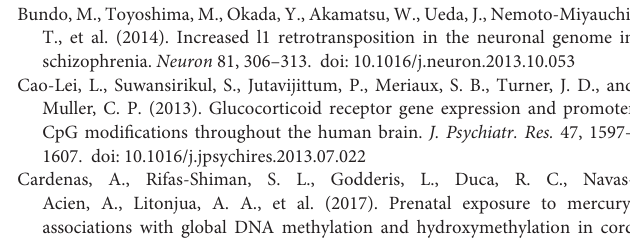
Supplementary Figure 1 | Representation of the linearity of expression levels for methylase and demethylase enzymes. (A) ALKBH1 vs. METLL4; (B) ALKBH1 vs. N6AMT1. Data from the GTEX portal on August 19th, (dbGaP Accession phs000424.v8.p2, 19/08/2020) (linear relationship was evaluated by Pearson analysis, R2 given in each panel, p < 0.01 in both cases). Supplementary Figure 2 | (A) Genotype-Tissue Expression data for human N6AMT1. Data were downloaded from the GTEX portal on August 19th, (dbGaP Accession phs000424.v8.p2, 19/08/2020). (B) Hierarchical clustering of sequence alignment and percentage sequence similarity for the methyl transferase N6AMT1. Supplementary Figure 3 | (A) Representative membranes for dot-blot quantification of the artificially methylated DNA control to demonstrate the lack of binding in synthetic DNA without 6mA and the strong signal from the artificially modified DNA. (B) Spike-in oligo sequence and sanger sequence